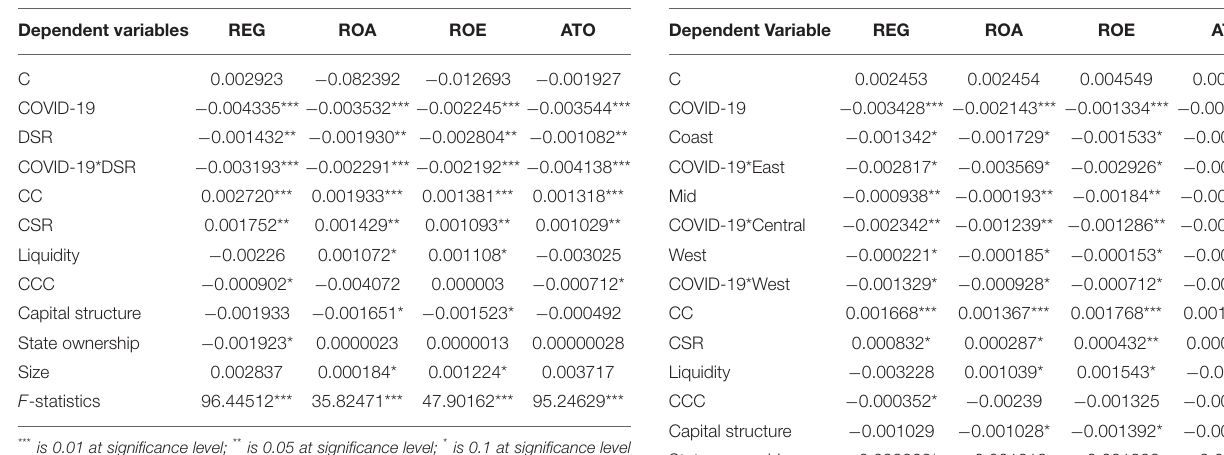
TABLE 6 | Generalized linear regression in serious regions.